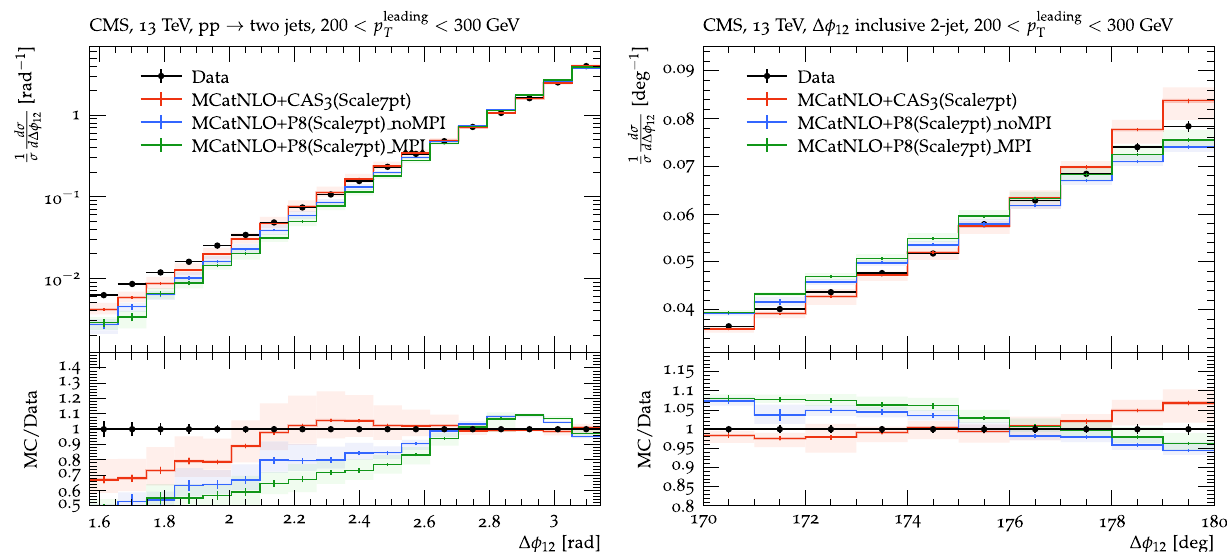
Fig. 8 Azimuthal correlation (cid:2)φ 12 over a wide range and (left) in the dictions from MCatNLO+ Pythia 8 and MCatNLO+CAS3. The uncer- > 200 GeV compared with pre- tainties in the MCatNLO+ Pythia 8 calculation are obtained from scale back-to-back region (right) for p leading T and associated shower variations, as described in the main text